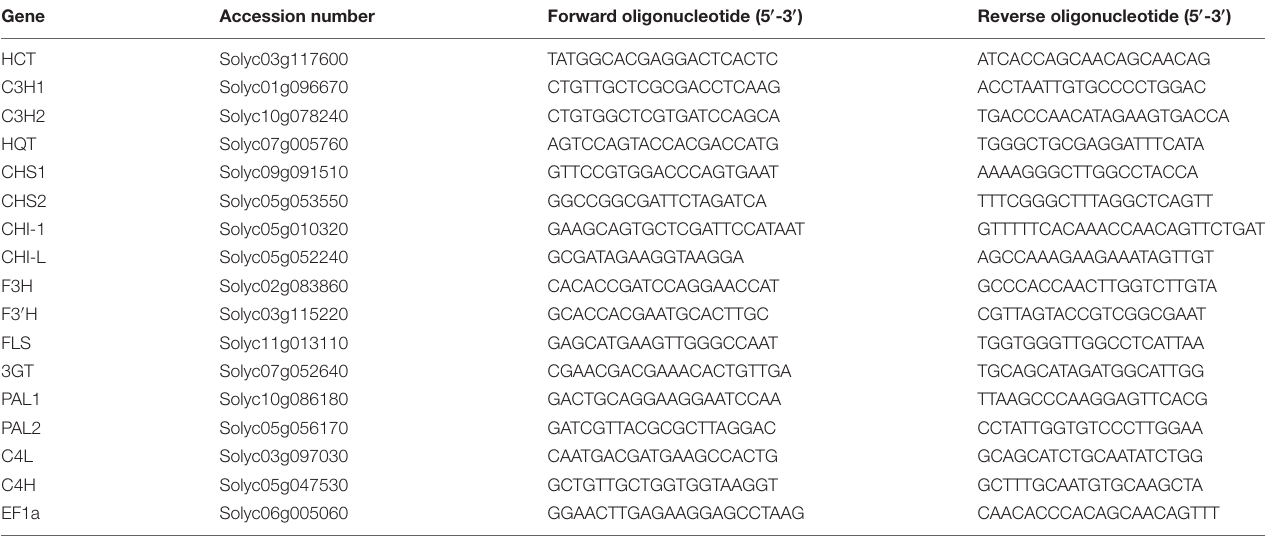
TABLE 1 | List of oligonucleotides used for qRT-PCR analysis. Gene Accession number Forward oligonucleotide (5 (cid:48) -3 (cid:48) ) Reverse oligonucleotide (5 (cid:48) -3 (cid:48)